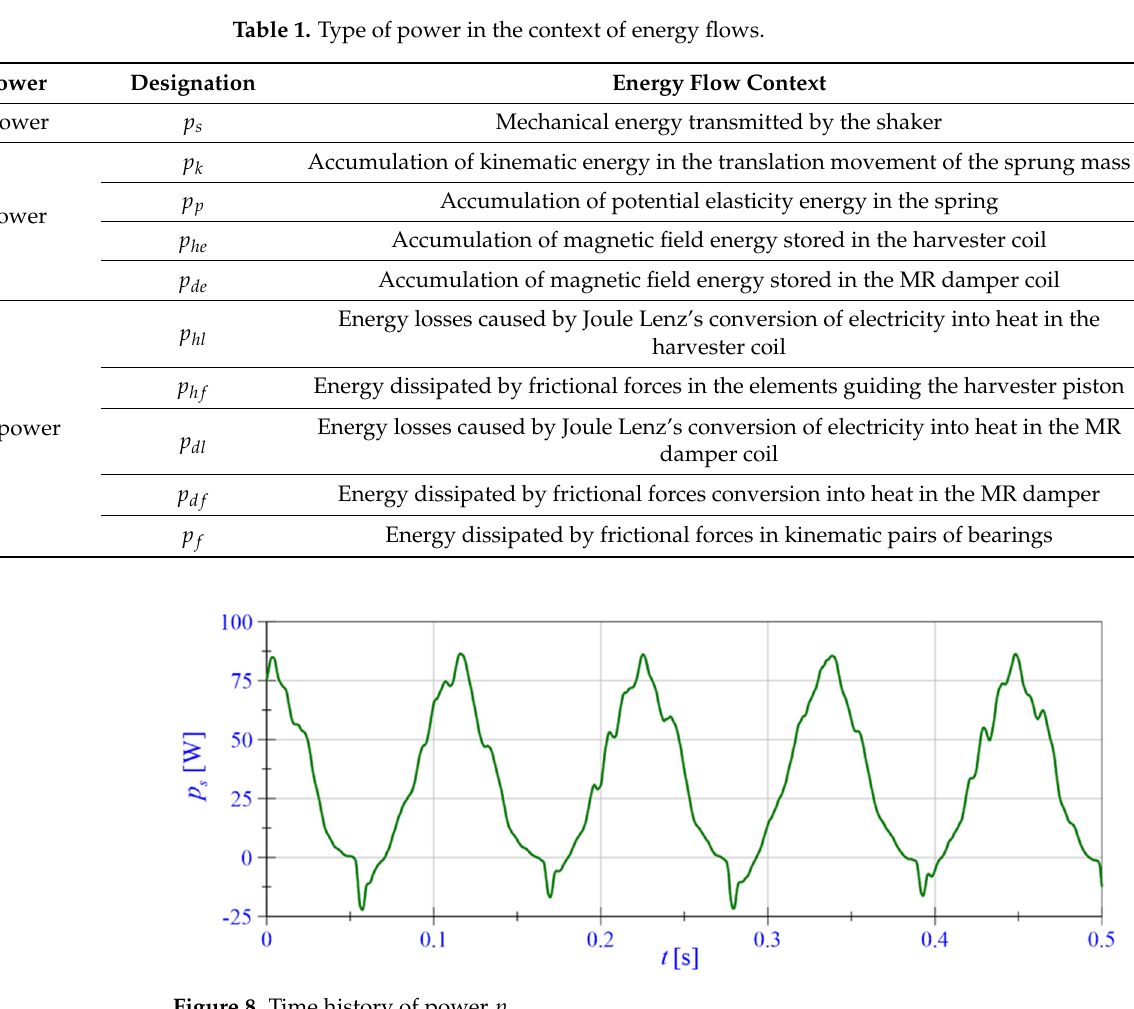
Figure 8. Time history of power p s